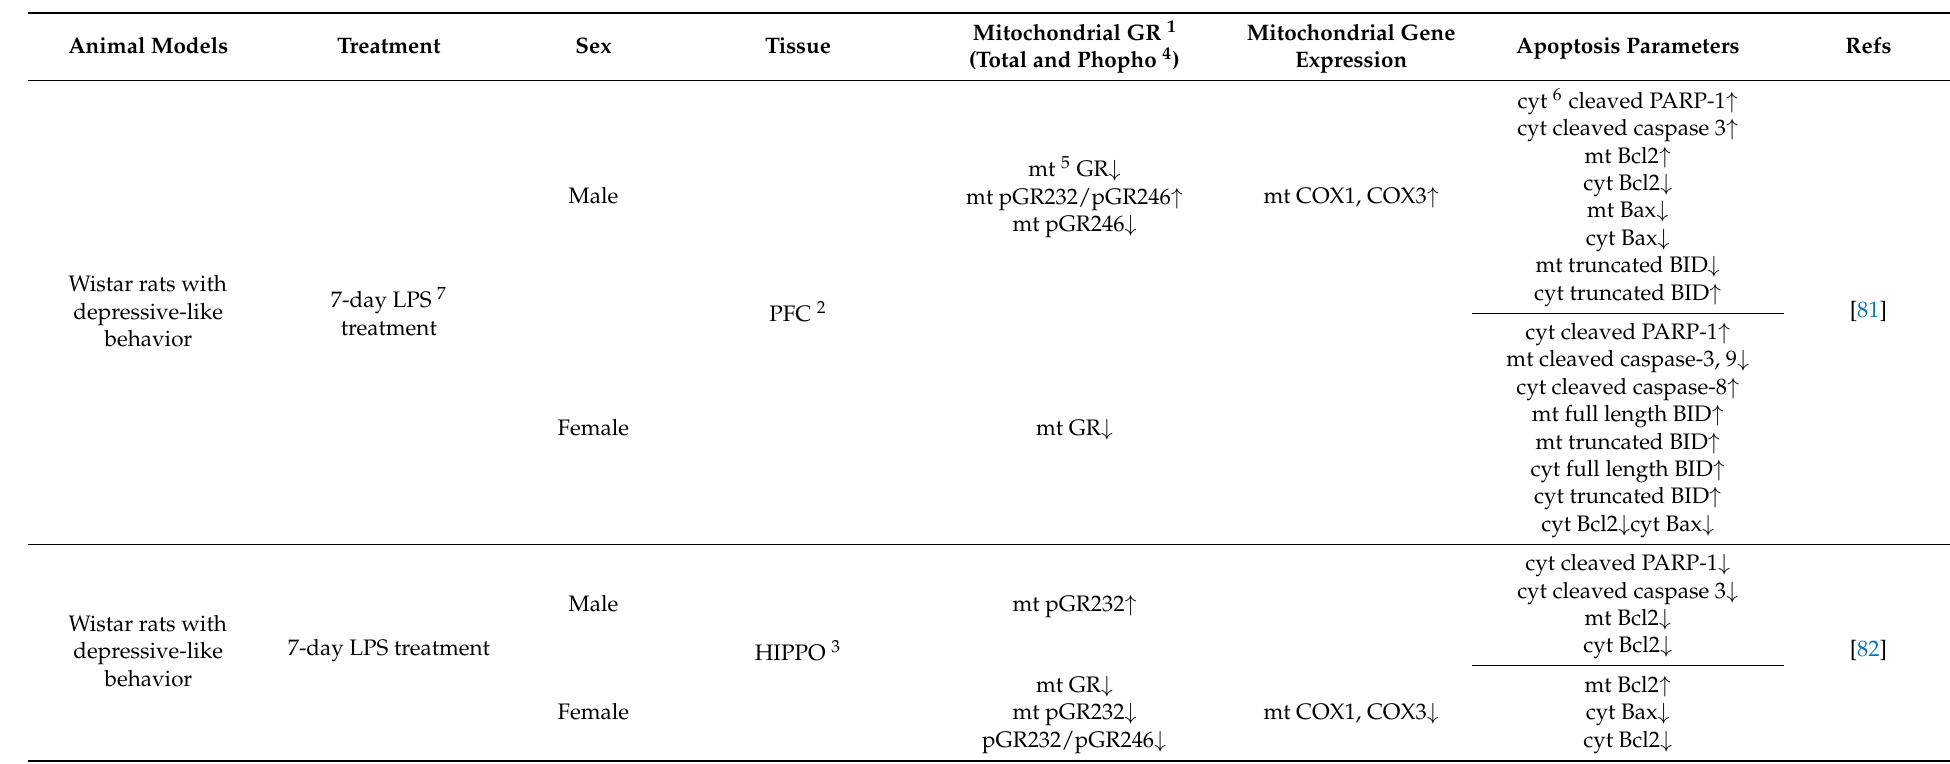
Table 4. Mitochondrial GR (total GR and phosphoGR isoforms) and apoptosis-related alterations in animals with depressive-like